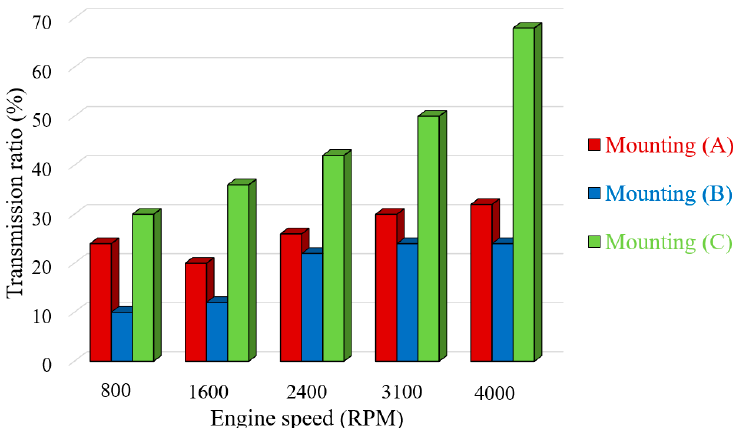
Figure 3. The transmission ratio of each mounting system at different engine speeds [14]. The rubber cone-and-shear mount offered the highest vibration isolation at all speeds.